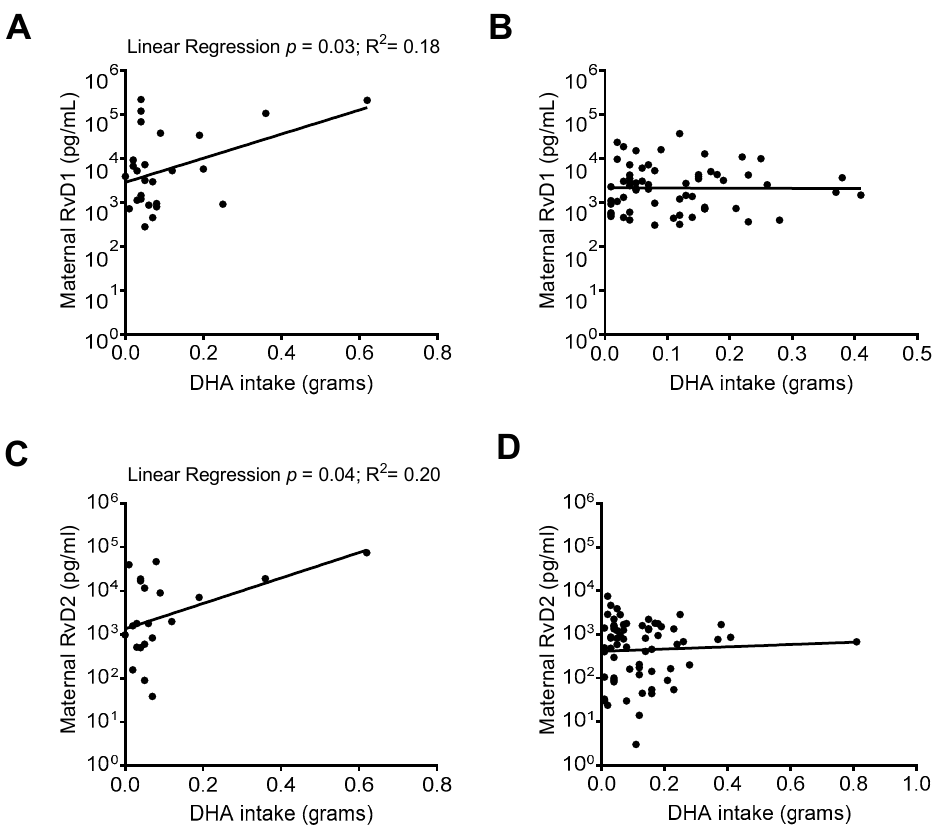
Figure 5. Relationship between DHA intake and maternal RvD1 and RvD2 plasma levels. Maternal RvD1 and RvD2 plasma levels were stratified based on infant NICU admission upon delivery and compared with DHA intake. ( A ) Linear regressions of maternal RvD1 levels and DHA intake in mothers with ( A ) and without ( B ) infant NICU admission upon delivery; Linear regression of maternal RvD2 levels and DHA intake in mothers with ( C ) and without ( D ) NICU admission upon delivery.